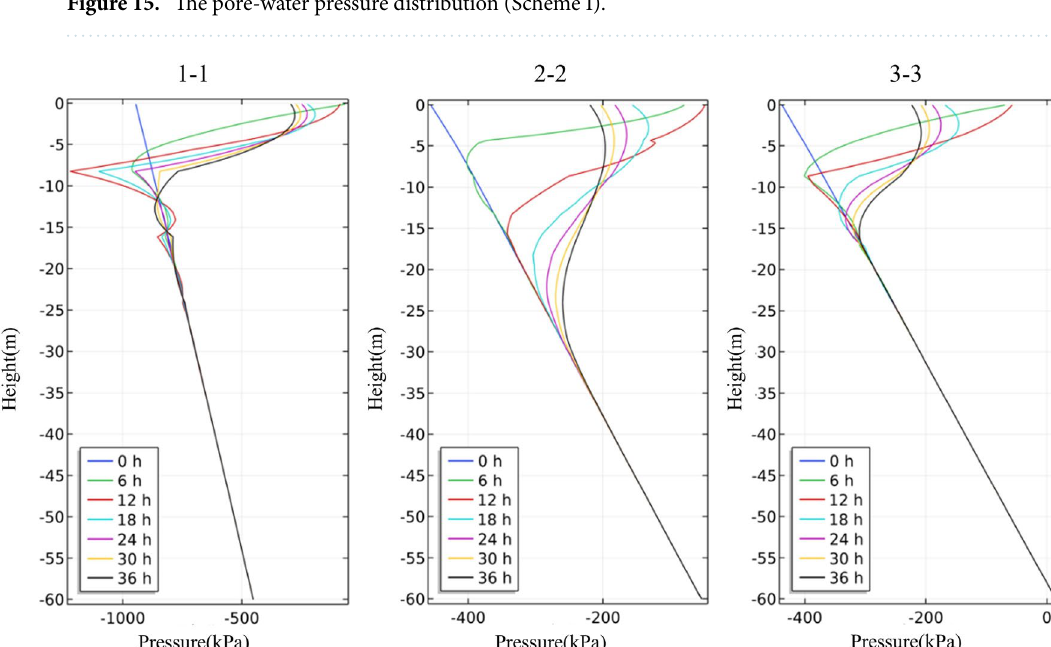
Figure 16. The variation of pore-water pressure in characteristic profiles(Scheme